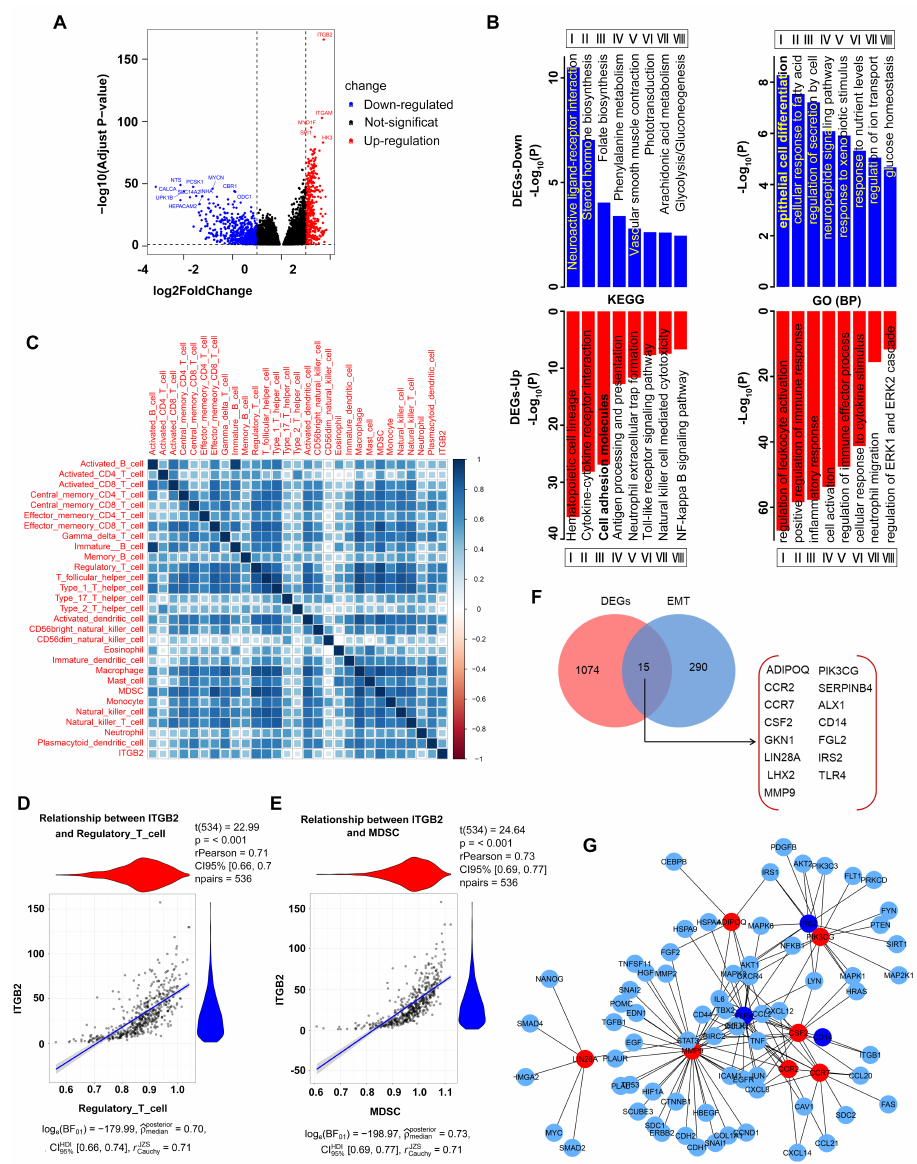
Figure 3. The aberrant expression of ITGB2 in NSCLC is associated with immune cell infiltration and EMT. ( A ) Four hundred and eighteen upregulated genes and six hundred and seventy − one downregulated genes were identified in the high-expression ITGB2 group based on the TCGA database. ( B ) GO (BP) and KEGG enrichment annotation of the DEGs in the high − expression ITGB2 group vs. low − expression ITGB2 group. ( C ) Analysis of the correlations between the aberrant expression of ITGB2 and immune cell infiltration in NSCLC. ( D , E ) The positive correlation between ITGB2 and Treg cells ( D ) and MDSC ( E ). ( F ) Venn diagram analysis of EMT − related genes in DEGs. ( G ) Protein − protein interaction (PPI) network constructed with the DEGs. Red nodes represent upregulated EMT − related genes, and blue nodes represent downregulated EMT − related